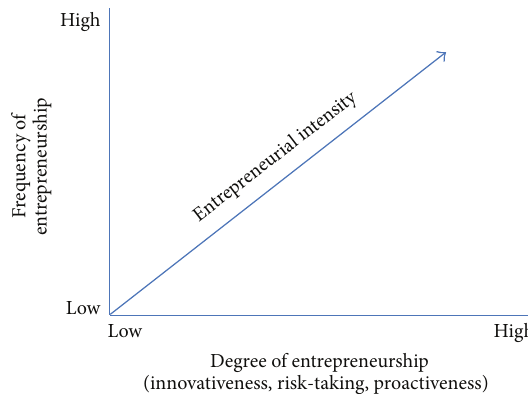
Figure 1: An illustration of entrepreneurial